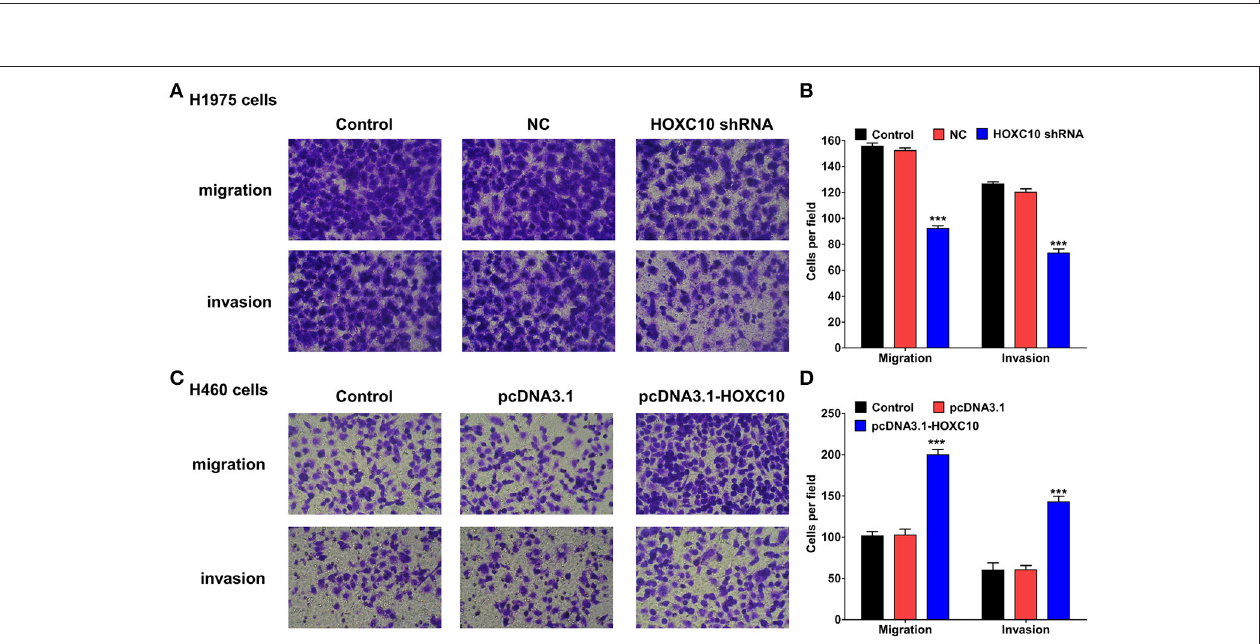
FIGURE 3 | HOXC10 inhibits cell migration and invasion in vitro . H1975 cells and H460 cells were transfected with indicated shRNA or plasmid, respectively. And then transwell assays were performed to determine the migration and the invasion of H1975 cells (A) and H460 cells (C) . Magnification, × 200. Three random fields of H1975 cells (B) and H460 cells (D) were photographed, and the cells in each field were calculated. Control, untreated cells; NC, scramble shRNA control. Data are presented as means ± SD , n = 3, *** p < 0.0001.